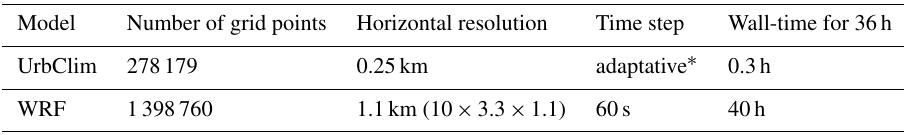
Table 2. Summary of the results of the benchmarking. The number of grid points represents the total number of grid points in the model domain, which is 121 · 121 · 19 in UrbClim, and 100 · 80 · 40 + 136 · 112 · 40 + 121 · 97 · 40 in case of WRF (taking into account the three nested